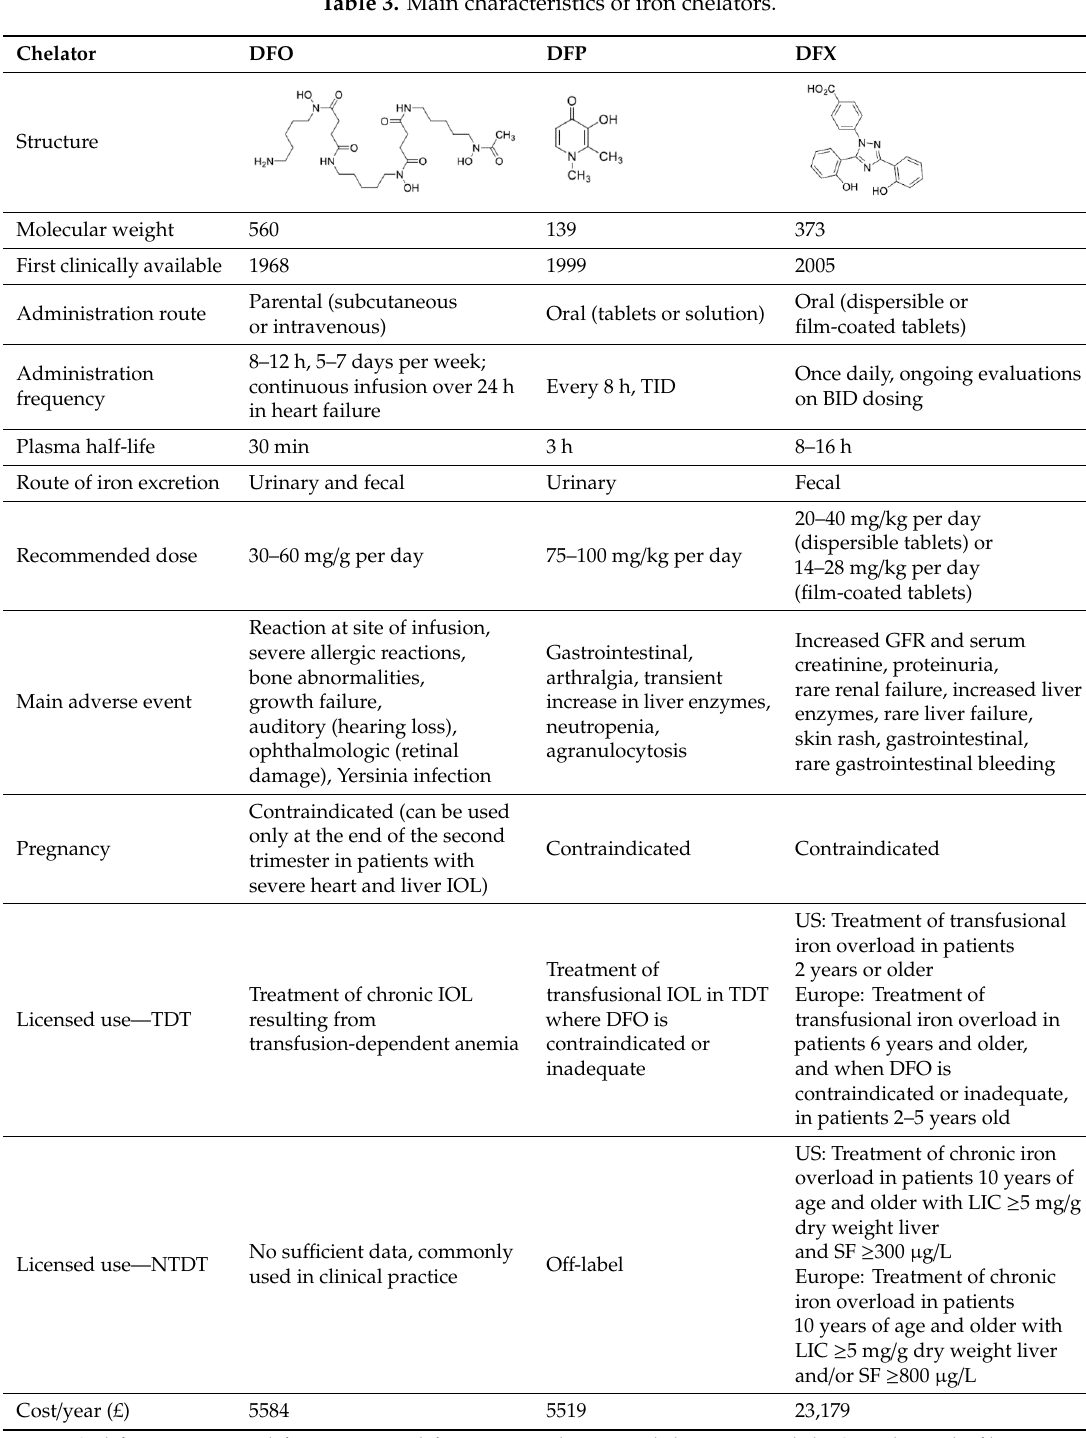
Table 3. Main characteristics of iron chelators.